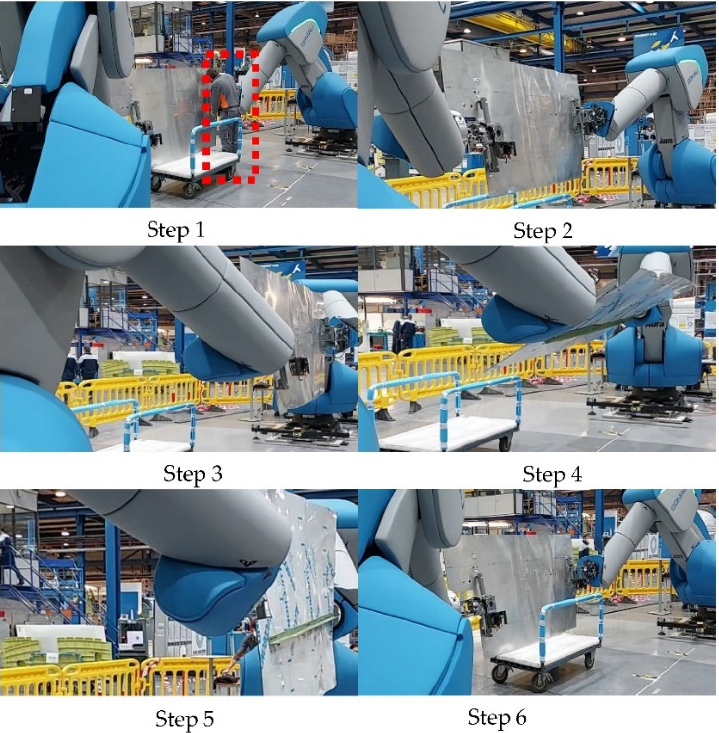
Figure 12. Step-by-step handling process.